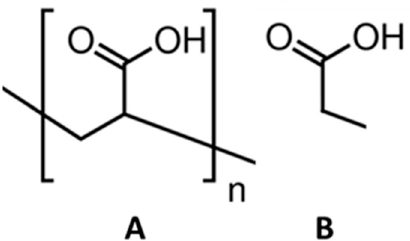
Sketch 1. Chemical structure of ( A ) polyacrylic acid, ( B ) propionic acid.